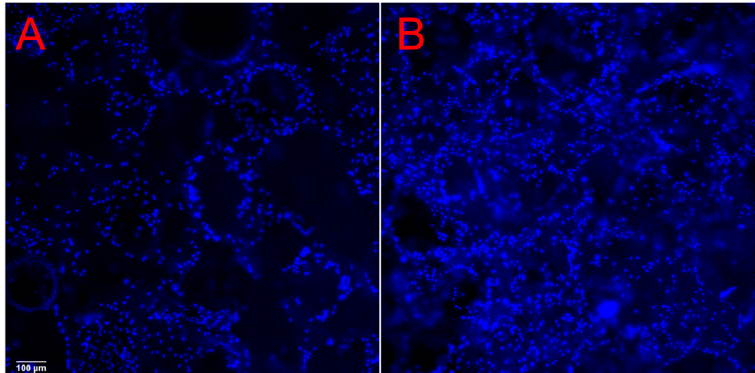
Figure 4. The cells demonstrated high viability throughout the period of observation as demonstrated by Calcein AM staining. Representative images of cells grown on PLA-HA scaffold are shown. ( A ) day 1, ( B ) day 3, ( C ) day 5, ( D ) day 7). Bar equals to 50 µ m and applied to all the images.